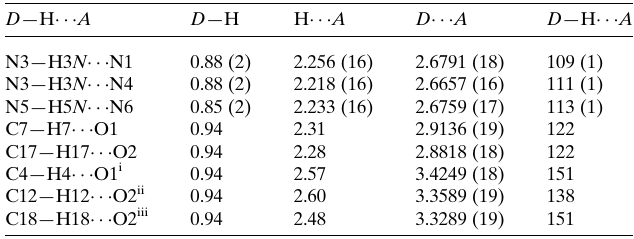
Table 1 Hydrogen-bond geometry (A˚ , (cid:2) ) for H 2 L1